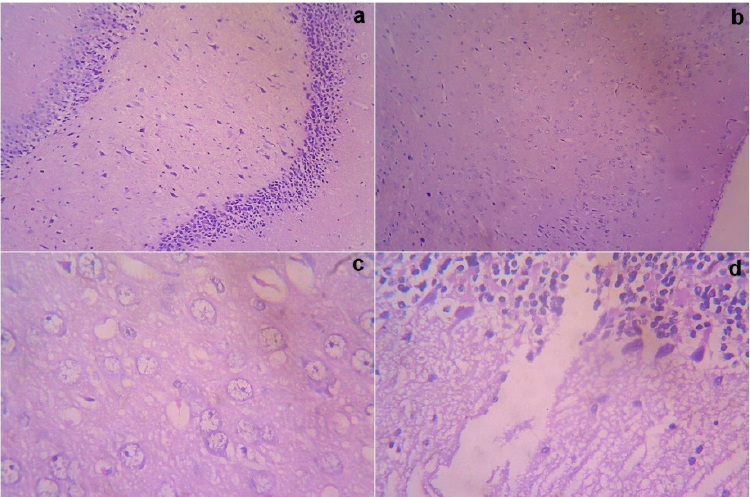
Figure 1. Gross histopathological examination of the brain following the infusion of mesenchymal stem cells obtained from decidua basalis in Wistar albino rats to assess the impact of safety, efficacy, and acute toxicity. Representative images of the brain section stand for ( a ) 10× showing a normal hippocampus with mild gliosis, ( b ) 10× showing a normal cerebral cortex, ( c ) 40× showing a hippocampus, and ( d ) 40× showing a normal molecular purkinje cell layer, respectively.